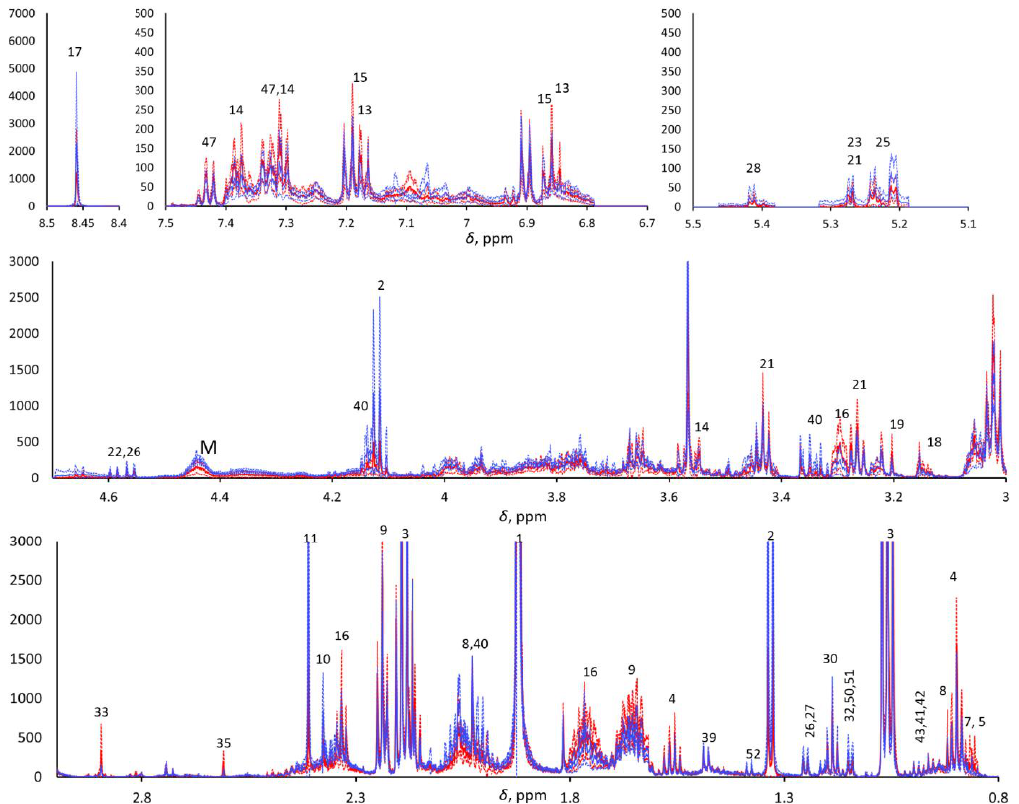
Figure 1. Five enlarged regions of the mean pSS (continuous red line) and mean HC (continuous blue line). 1 H CPMG NMR spectra (±standard deviations, dotted lined; red and blue for pSS and HCs, respectively). M indicates macromolecules.